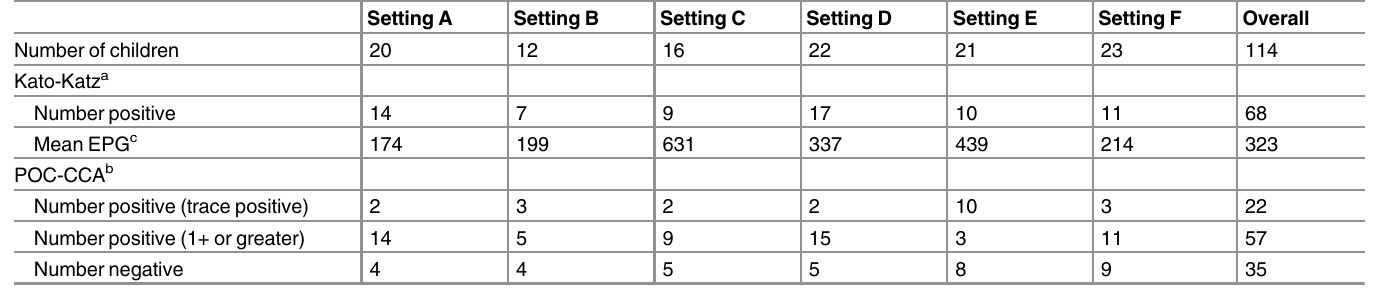
Table 1. Demographic and epidemiologic characteristics of six neighborhoods in Azaguié Ahoua, south Côte d ’ Ivoire.